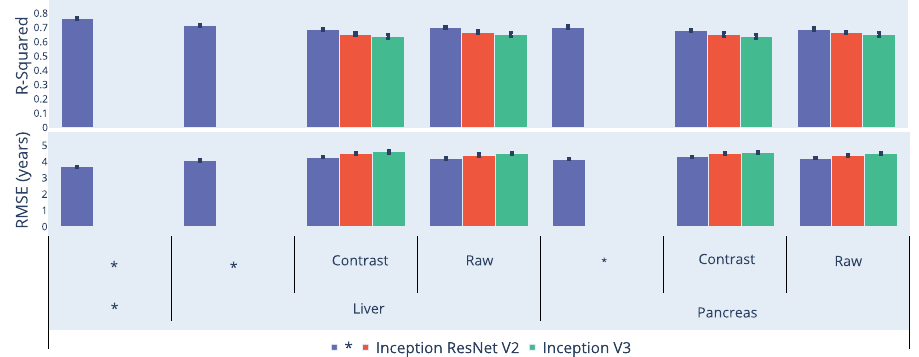
Fig. 2 Prediction performance (R 2 and RMSE) for AbdAge, Liver and Pancreas Age models. “ Contrast ” denotes contrasted image. *represent ensemble models. R2: R-squared of predicted versus actual age. RMSE: Root-mean-squared error. Error bars represent 2 SD of the bootstrapped left arm impedance (correlation = 0.055), and whole body impe- (correlation = 0.050), systolic blood pressure (correlation = 0.048), dance (correlation = 0.042). 66.7% of blood pressure biomarkers are and mean arterial pressure (correlation = 0.046). associated with accelerated abdominal aging, with the two associa- tions being with diastolic blood pressure (correlation = 0.050) and systolic blood pressure (correlation = 0.036). 46.7% of pulse wave analysis biomarkers are associated with accelerated abdominal aging, with the three largest associations being with diastolic blood pressure